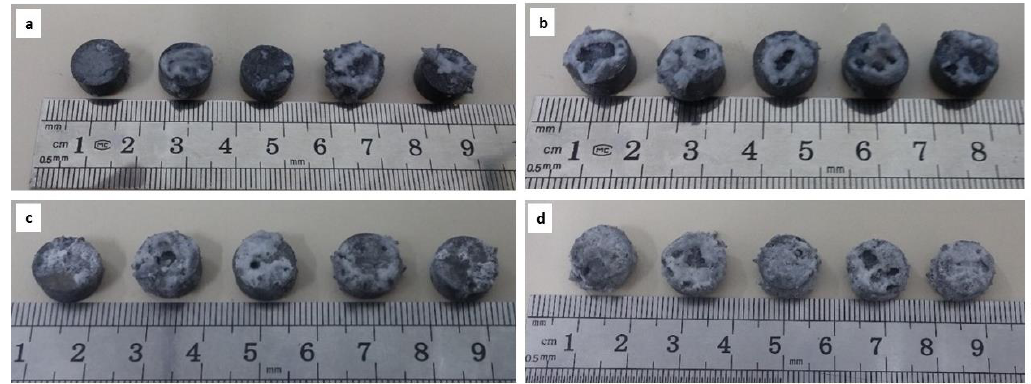
Figure 7. Fractography analysis of tested alloys obtained by scanning electron microscopy (SEM) ( a ) Mg-5%Zn—SE image, ( b ) Mg-5%Zn-1%Nd—SE image, ( c ) Mg-5%Zn-2%Nd—SE image, ( d ) Mg- 5%Zn-3%Nd—SE image, ( e ) Mg-5%Zn—BSE image, ( f ) Mg-5%Zn-1%Nd—BSE image, ( g ) Mg-5%Zn-